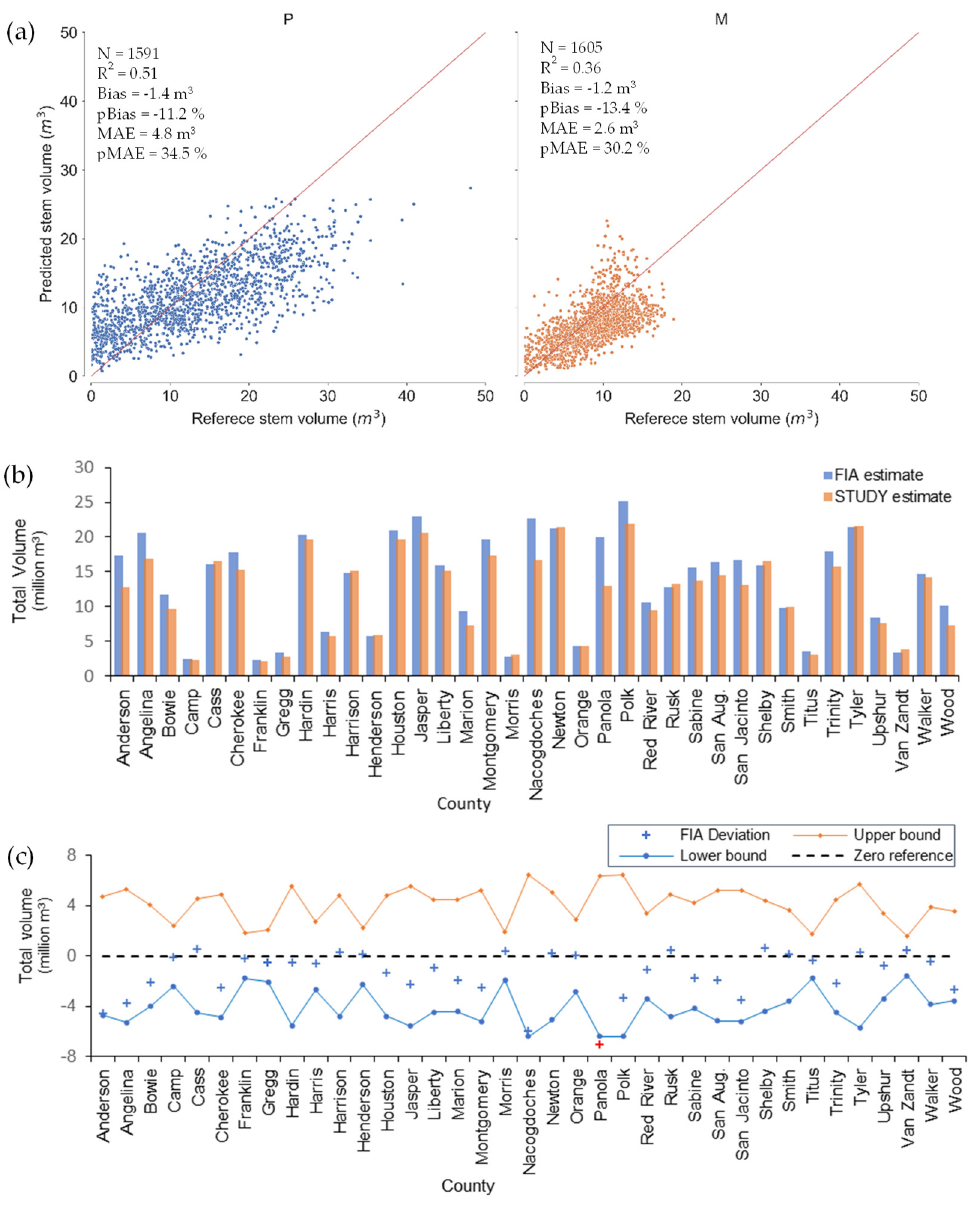
Figure 8. Comparison of study stem volume estimates to independent and FIA county-level stem volume estimates: ( a ) predicted vs. reference stem volume per pixel in cubic meter from independent sites in pines (left) and mixed forests (right). The red dashed line indicates the expected 1:1 relationship between the two estimates. ( b ) Bar chart showing study and FIA county-level stem volume estimates. ( c ) Deviation of study stem volume from FIA estimates with lower and upper 95% confidence limits calculated based on FIA per-county sampling error percentages. Deviations marked by red crosses fall outside the 95% confidence limits, which indicates significant differences between this study and FIA estimates. N is the number of pixel samples used in the assessment.